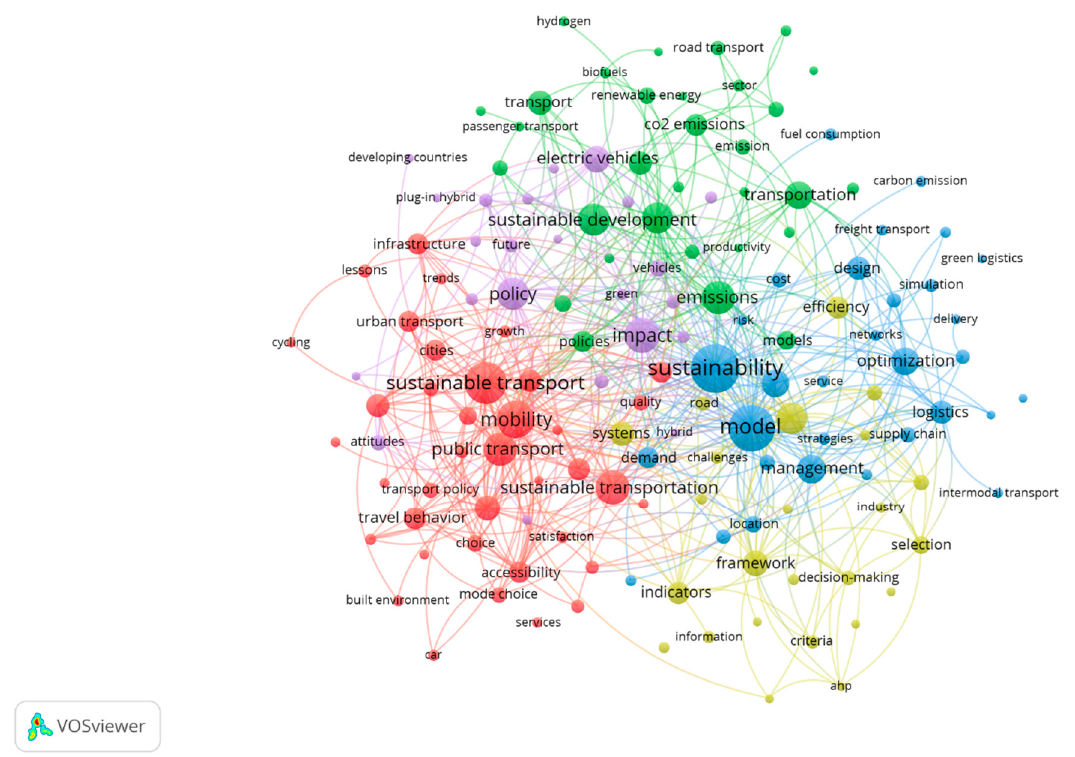
Figure 2. Co-Word cluster map. Source: own elaboration based on the created database.